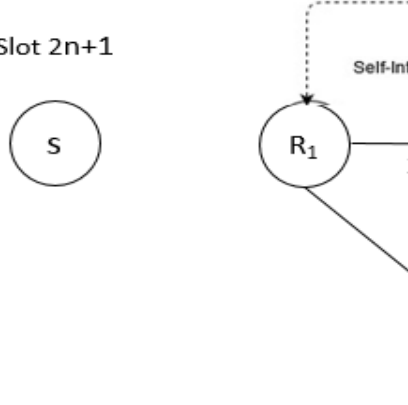
Figure 5. Signal transmission in the 2( n +2)th time slot . 2.3. Amplify and Forward ( AF ) Relaying Scheme This involves two phases: the first phase is the same as the DF scheme as demon- strated in Figure 3; in the 2 n th time slot, the R 1 , R 2 , and E signals are received, and the relevant equations are represented by (5)–(7). In the next time slot, the relay sends the amplified signals to the destination using the Amplify and Forward Scheme and by jam- ming the signal source to the eavesdropper. Therefore, in the (2 n + 1)th time slot, the signal received R 2 and E as follows: 𝑦 (cid:3019) (cid:3118) (2𝑛 + 1) = 𝐺(cid:3495)(1 − 𝜌)𝑃 (cid:3019) (cid:3117) ℎ (cid:3019) (cid:3117) (cid:3019) (cid:3118) ∗